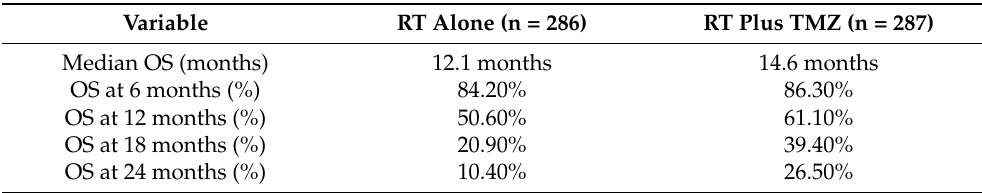
Table 2. Overall survival of glioblastoma patients with radiation therapy alone compared to radiation therapy plus temozolomide [5].